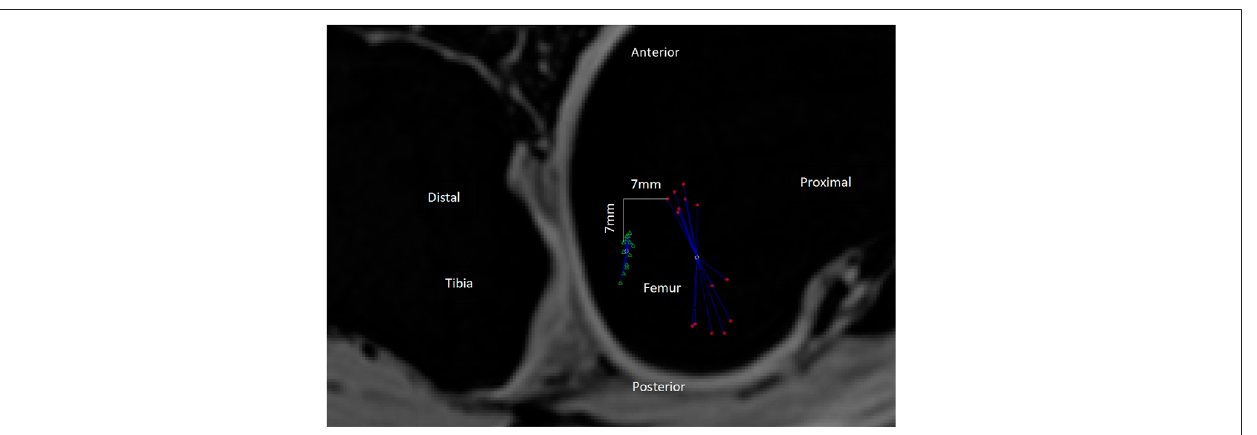
FIGURE 5 | PC value is the standard deviation of the distances between the reference point ’ s trajectory coordinates and the average coordinate. As shown in the fi gure, the green triangle ’ s trajectory is more gathered than that of the red asterisk, so the PC value of the green triangle should be less than that of the red asterisk. The actualcalculationresultofthePCvalueisindeedthecase[13.7 mm(redasterisk)and4.5 mm(greentriangle),respectively].ThesmallerthePCvalue,themoregathered is the trajectory and the more stable is the reference point during the 0 – 130 ° knee fl exion. In this Figure 2D distances are used as an illustration, but in the actual experiment,3DdistancesareusedtocalculatethePCvalue.Redasterisk:thetrajectoryofthemedialcondyleofTEA.Greentriangle:thetrajectoryofthereferencepoint 7 mm distal and posterior to the medial condyle of TEA. White circles: there are two white circles, representing the average position of the red asterisk and the green triangle, respectively. Blue line segments: each line segment represents the distance between a reference point coordinate and the average position of all coordinates.